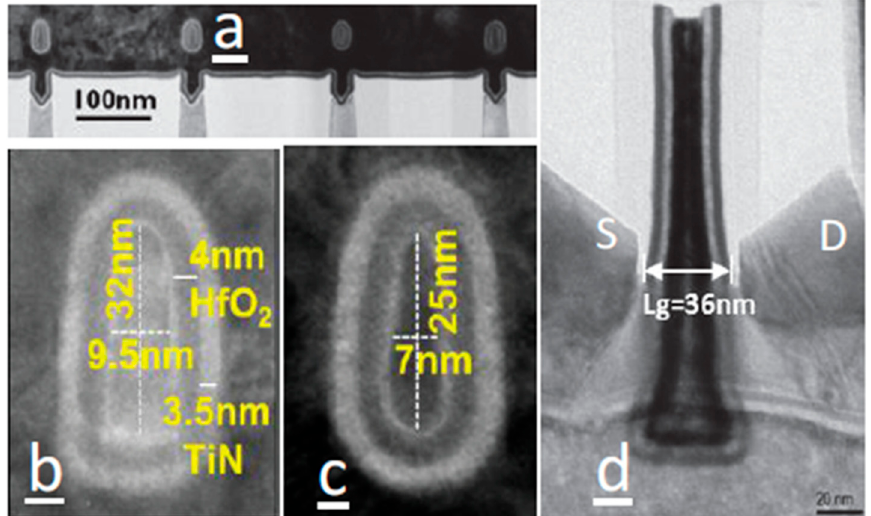
Figure 30. TEM micrographs of completed devices. ( a ) Devices across one gate pattern. ( b ) 9.5 nm-wide channel obtained from 2 cycles of WHALE* where 1 nm conformal interfacial layer was grown by ALD before HfO 2 deposition. ( c ) 7 nm-wide channel obtained from 5 cycles of WHALE* with the same gate stack as shown in ( b ) are used, and ( d ) along the trench showing L g of 36 nm [186]. * WHALE stands for Wet HCl-based Atomic Layer Etch.